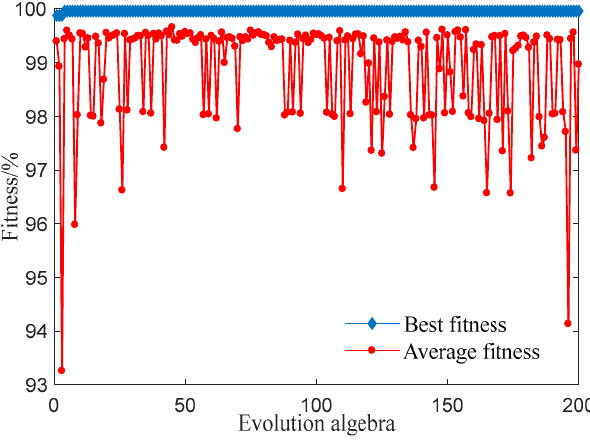
Figure 11. Fitness (accuracy) curve of the PSO based parameter optimization.